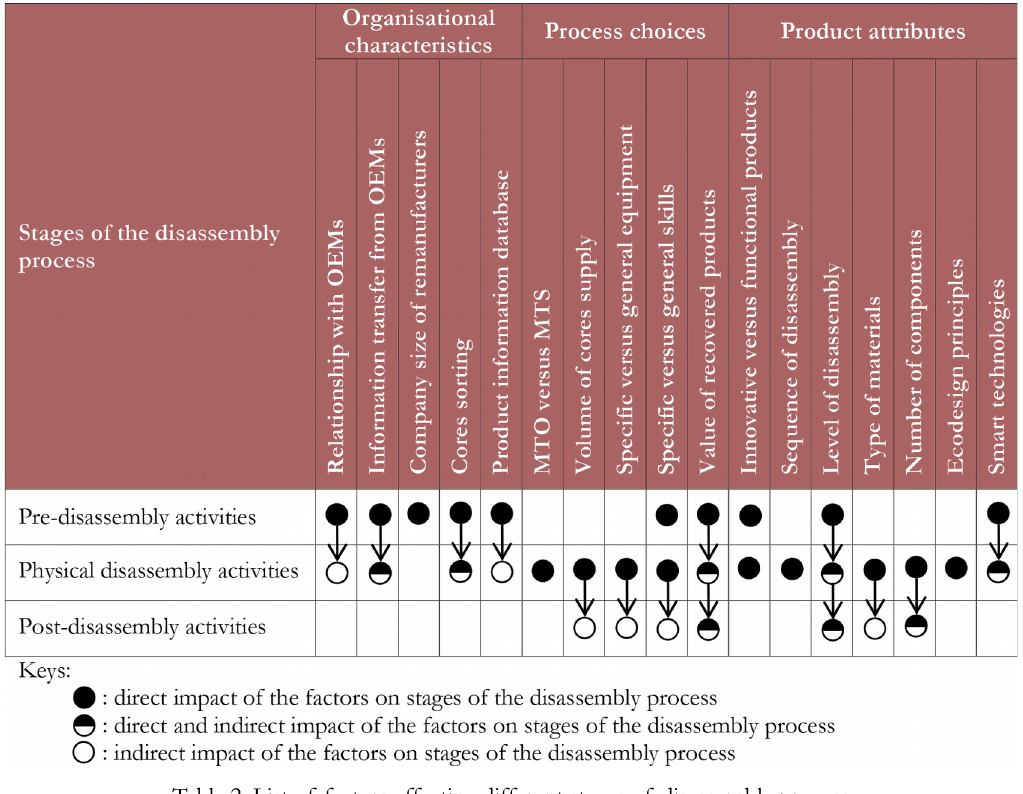
Table 2. List of factors affecting different stages of disassembly